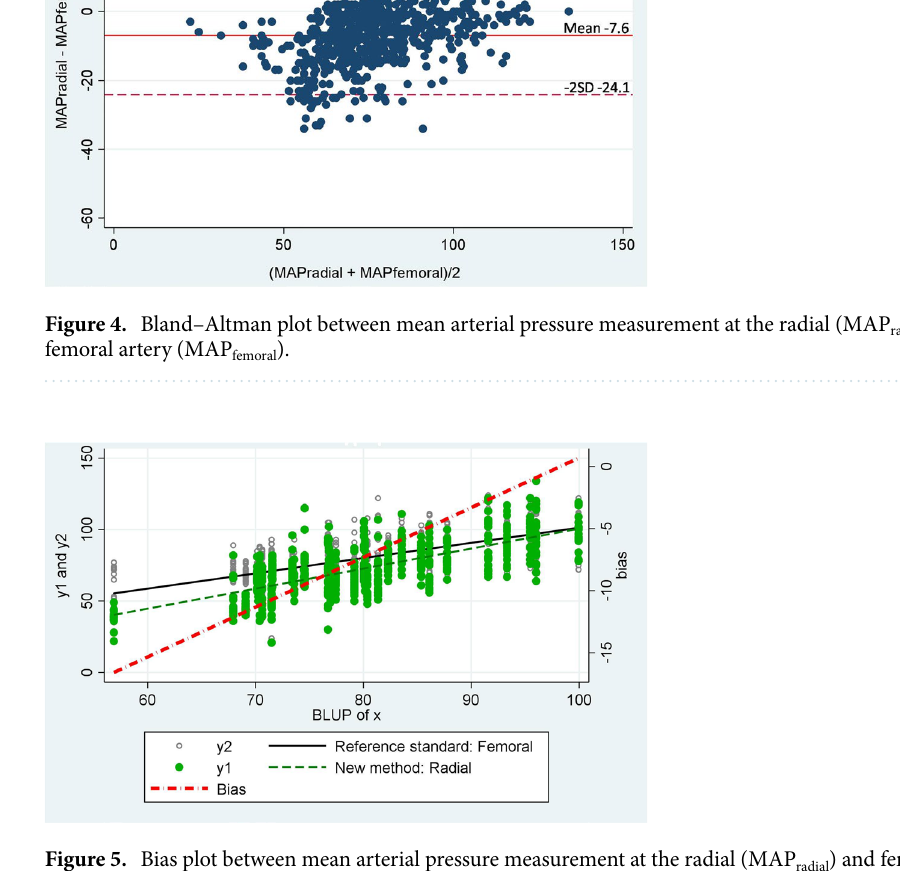
Figure 5. Bias plot between mean arterial pressure measurement at the radial (MAP radial ) and femoral artery (MAP femoral ). BLUP: best linear unbiased prediction, X = mean arterial pressure, y1 = mean arterial pressure from radial artery, y2 = mean arterial pressure from femoral artery. The second scale on the right shows the relationship between the estimated amount of bias and the predicted value ˆ x i